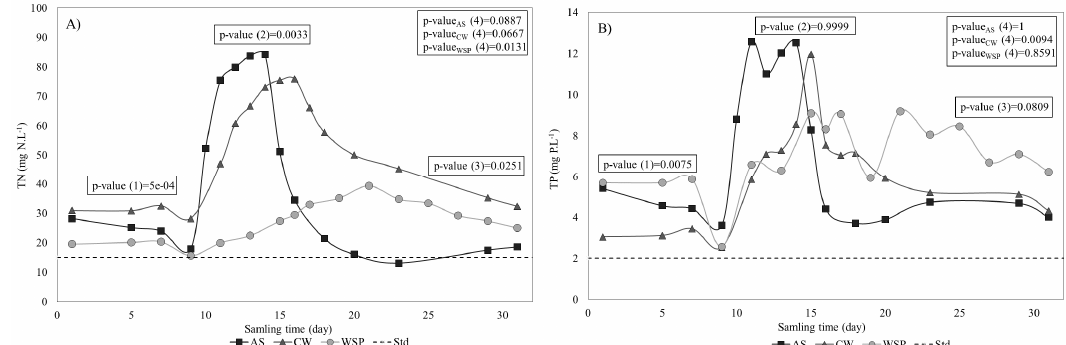
Figure 3. The nutrient effluent concentration of the Activated Sludge (AS), Constructed Wetland (CW) and Waste Stabilization Pond (WSP) with the p -value of four statistical tests during the peak load scenario (( A ): TN, ( B ): TP). The dot line represents the threshold of the effluent discharge according to the Flemish Environmental Legislation.